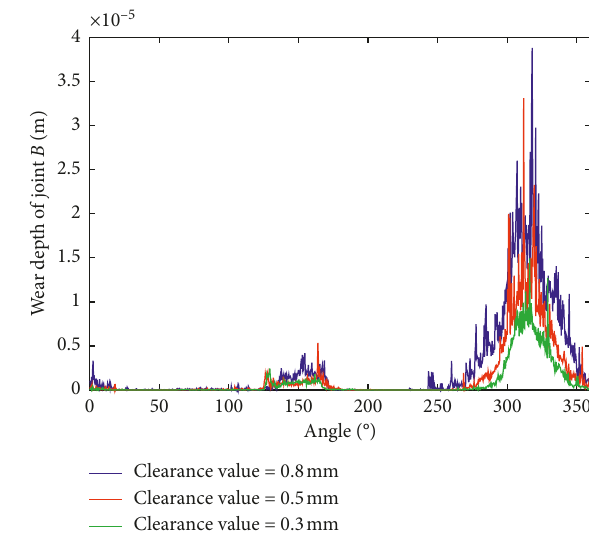
Figure 29: Wear depth at joint A .